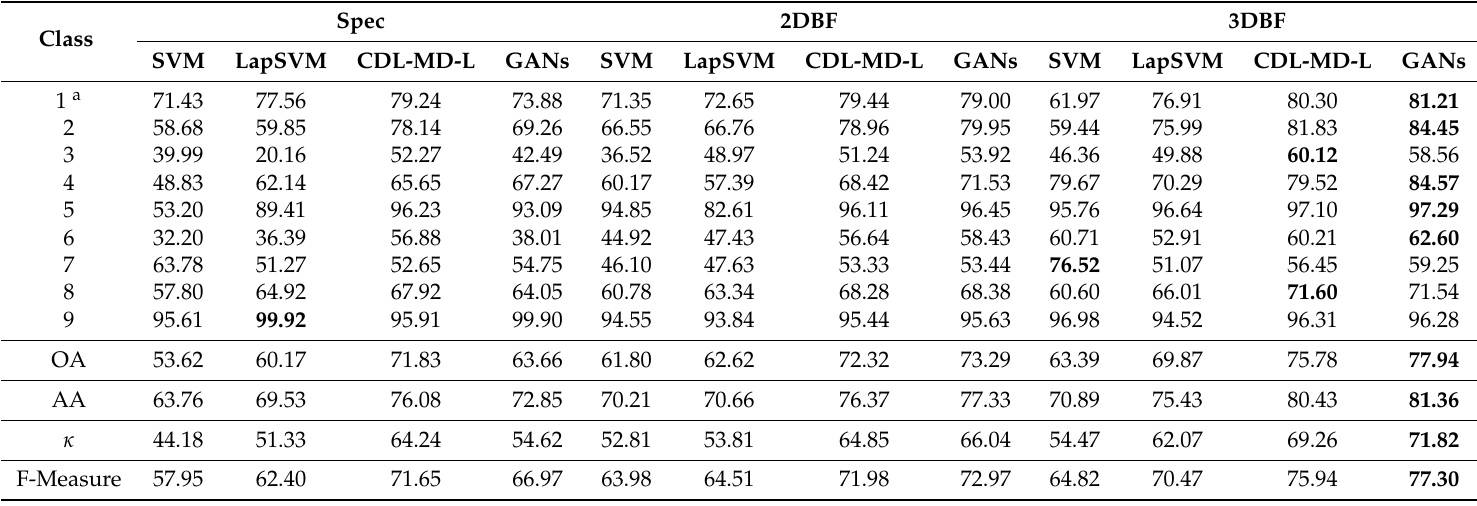
Table 5. Classification accuracy (%) of various methods for the University of Pavia data with 5 labeled training samples per class, bold values indicate the best result for a